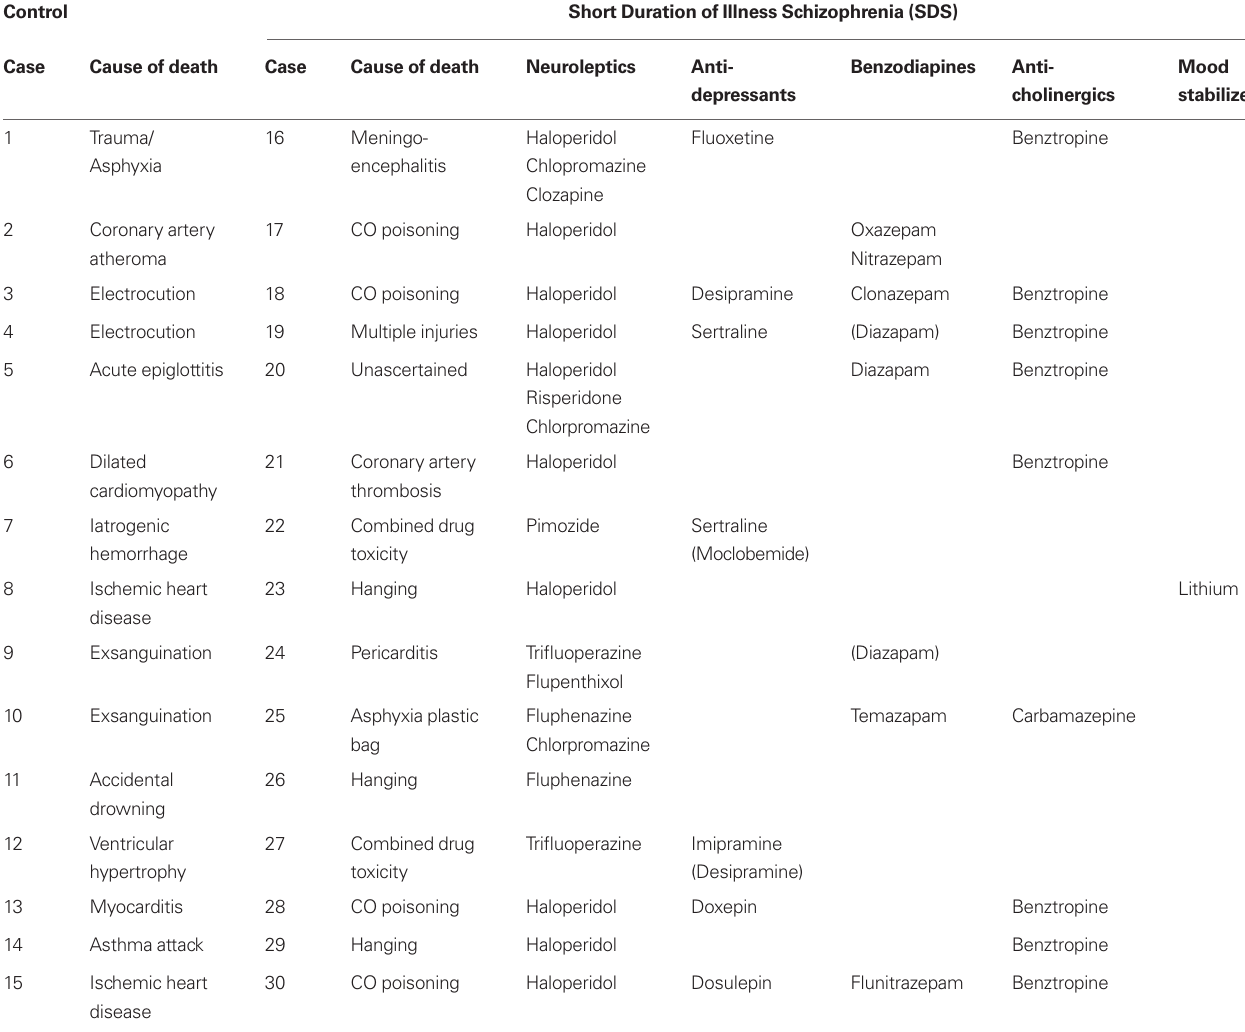
Table 2 | The cause of death and medication history of the subjects used in this study.